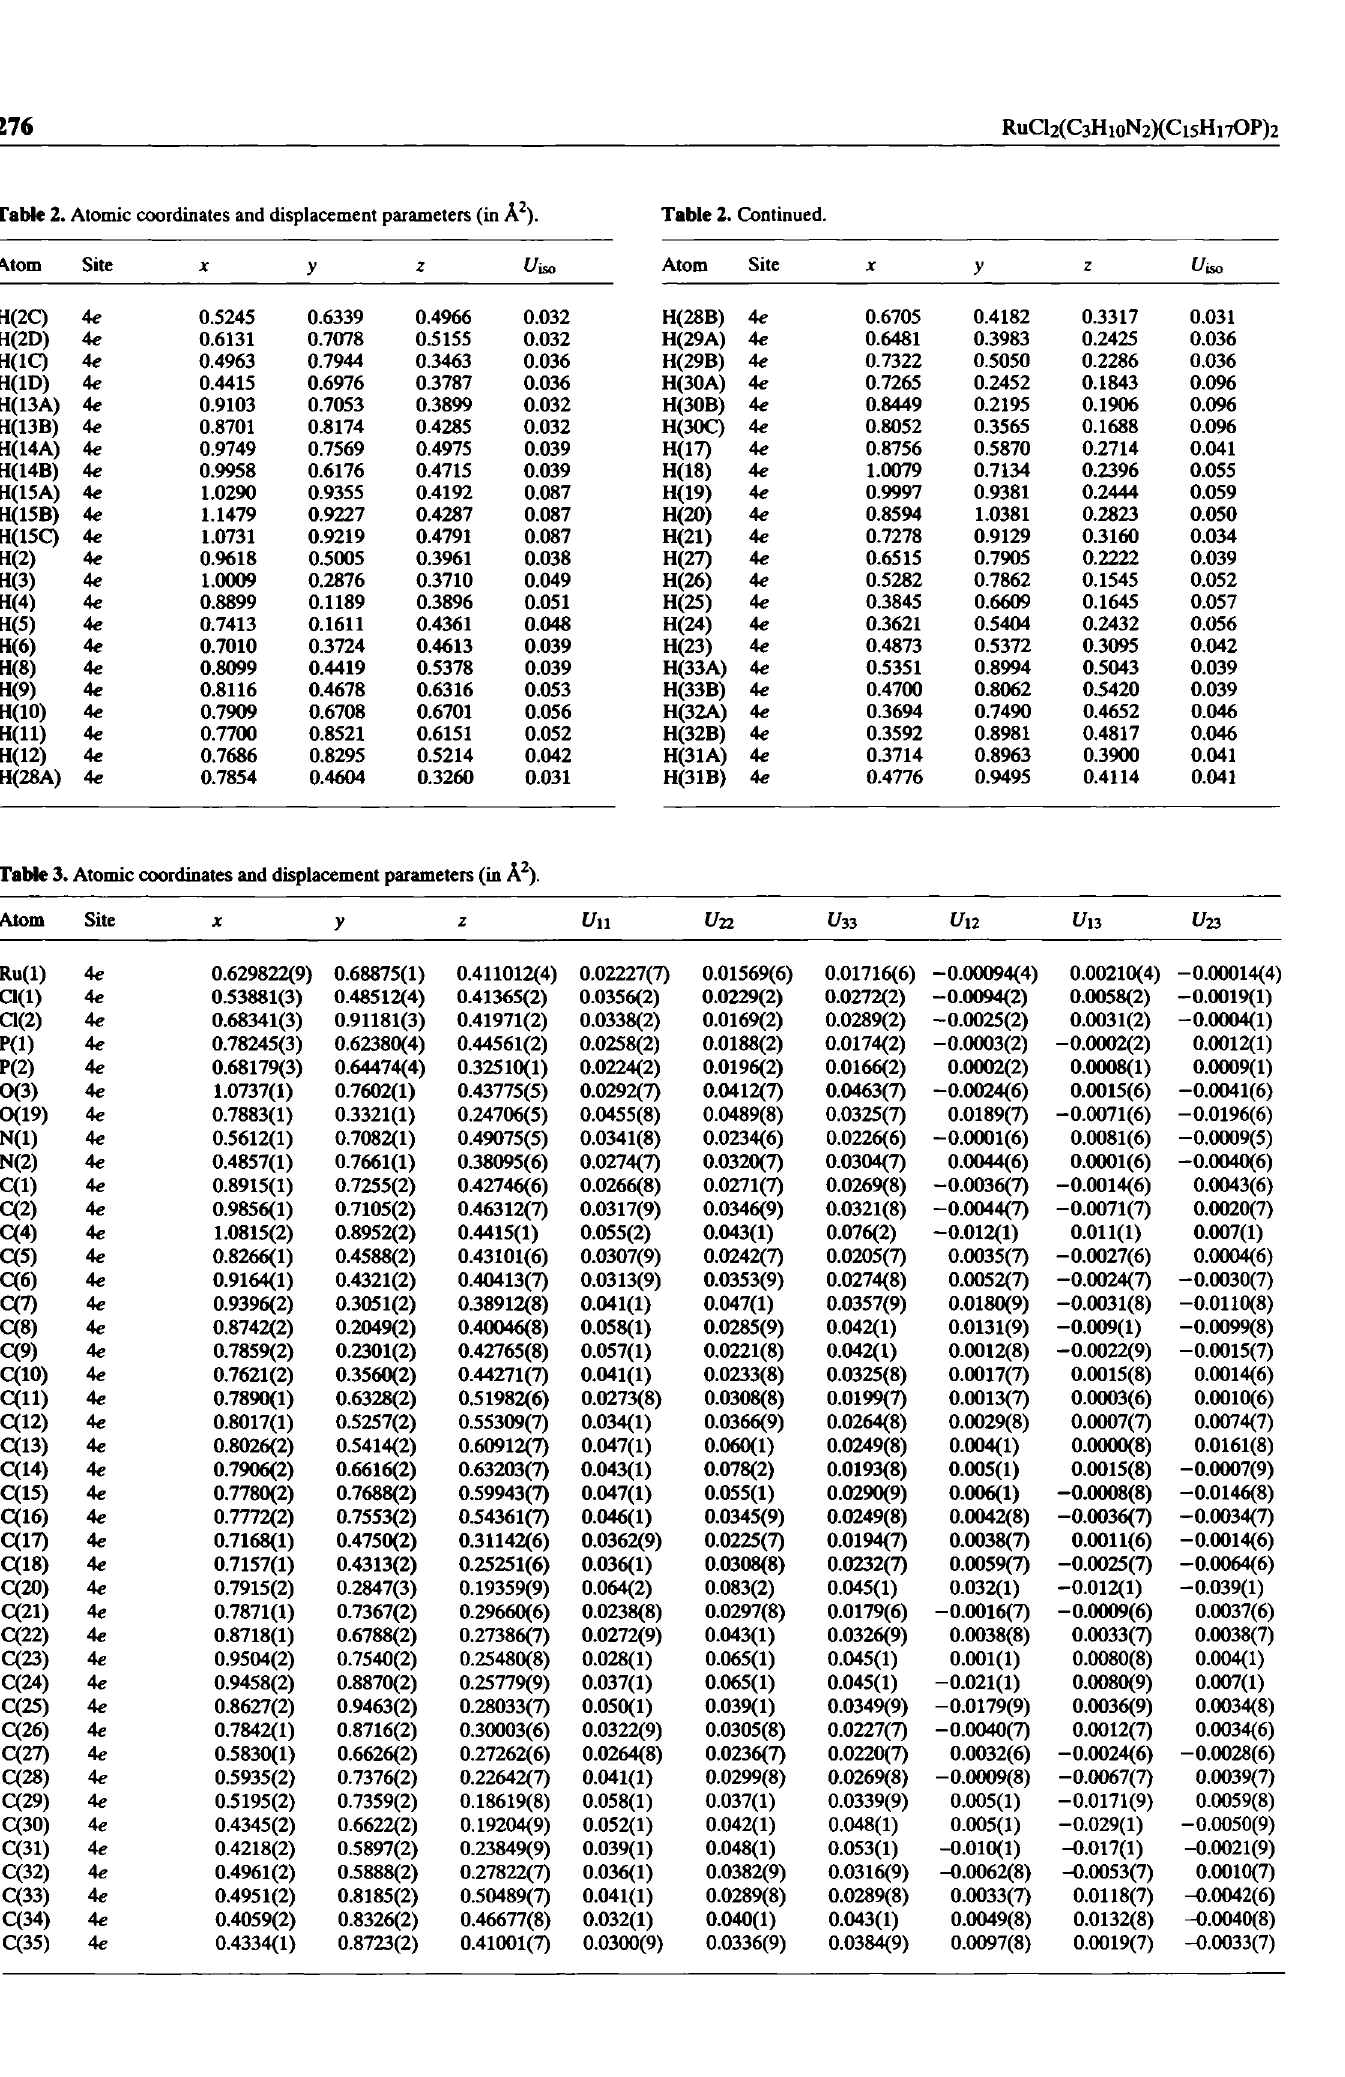
Table 3. Atomic coordinates and displacement parameters (in A 2